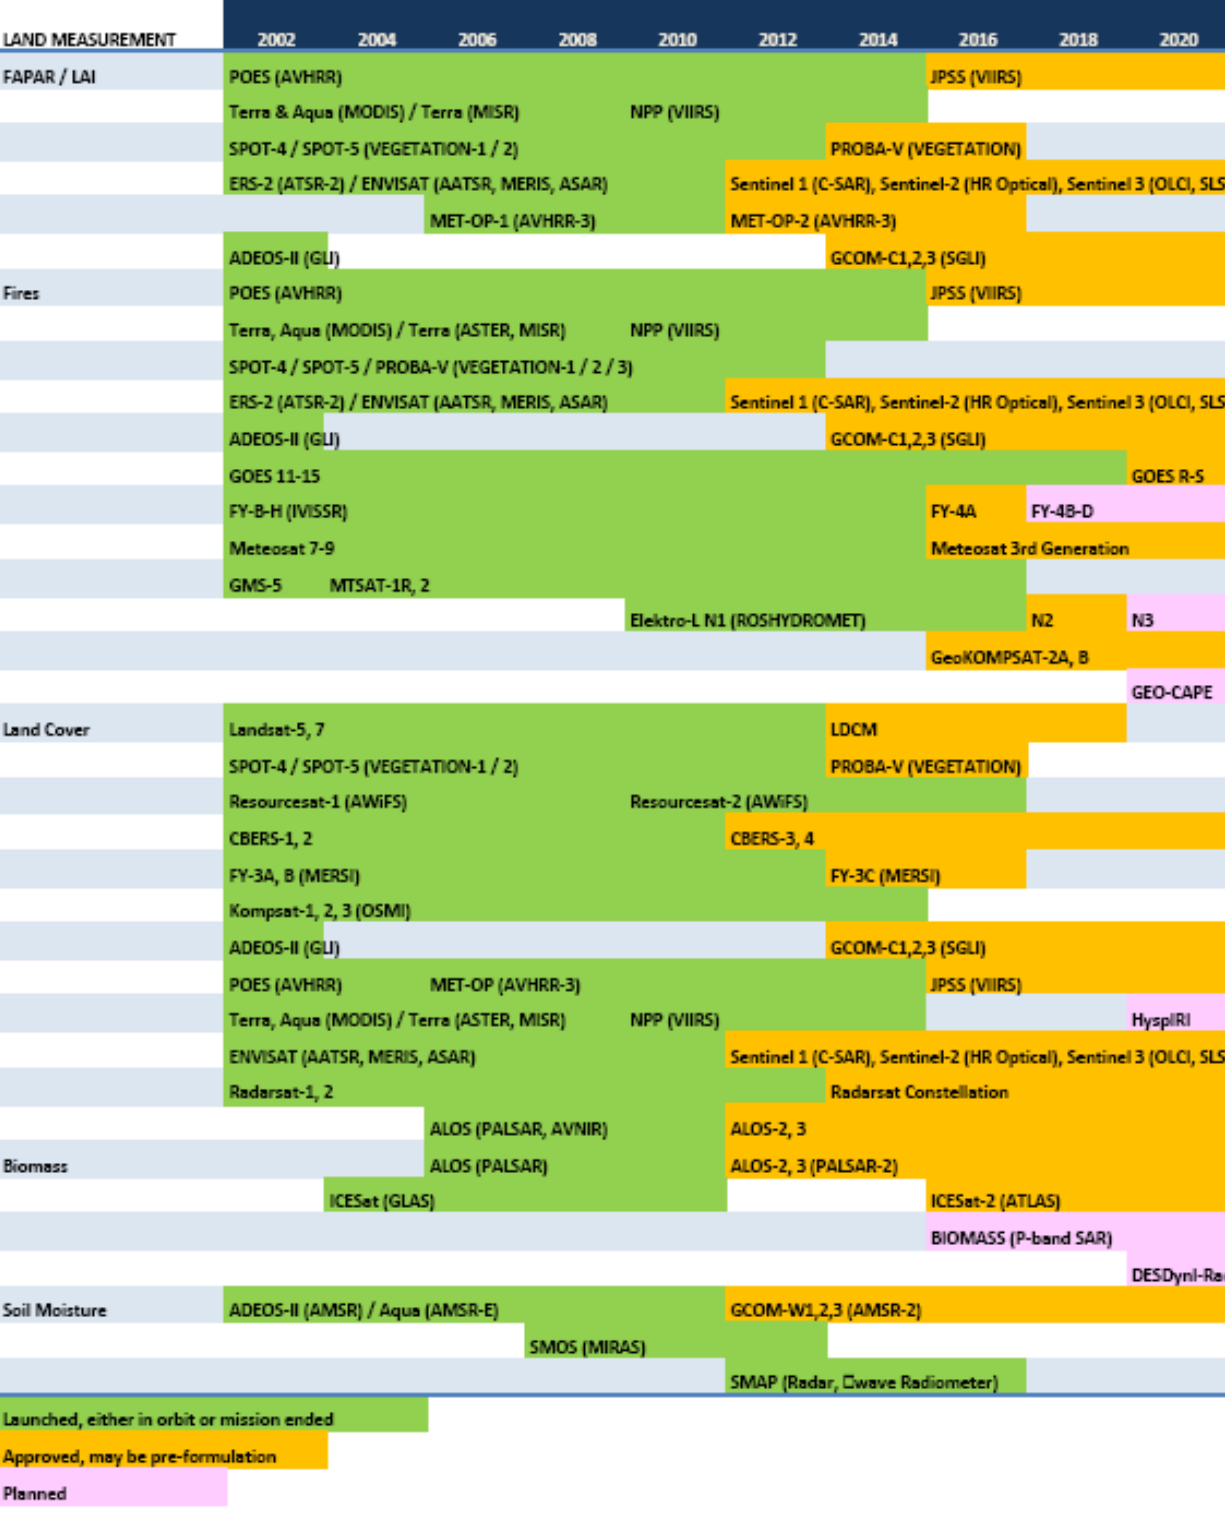
Fig. 7C. Satellite missions ongoing and planned. A. for XCO observations with PBL sensitivity; launched or near-launched (green), approved - maybe at pre-4 formulation stage (tan), and planned missions (pink). Outlined dashed black are active sensors 5 (Lidar). B. Same for ocean carbon cycle satellite missions. C. Same for terrestrial carbon cycle. 6